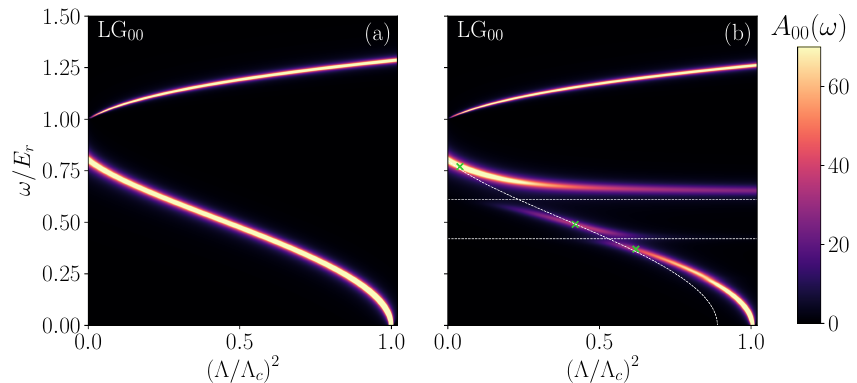
Figure 4: Distribution of the spectral weight in the LG a) when no phase-modulation is applied to the laser, B Ω = ω + 0.19 E . The remaining parameters are ∆ T r = 10 − 3 w L and κ = 0.02 E with the parameters described in section 2.3. The hor- H r 0 izontal dashed lines in b) represent the effective detunings of higher-order modes, while the decreasing dashed line represents the position of the spectral line from